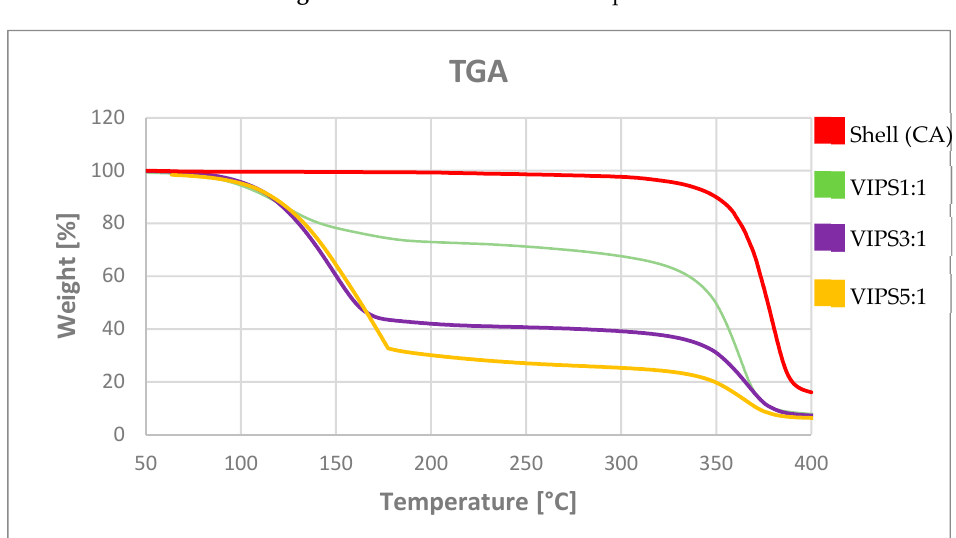
Figure 6. TGA plot of VIPS capsules.